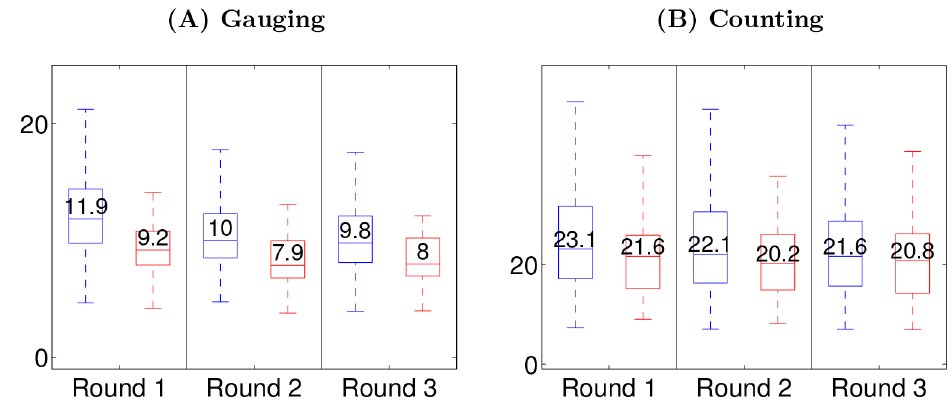
Fig 5. (A) gauging game ; (B) counting game . From left to right: (Boxplot 1, 3 and 5, in blue) Root mean square distance from individual opinions to truth ( E i ( r )); (Boxplot 2, 4 and 6 in red) Root mean square distance from mean opinion to truth. Values shown for the counting game have been scaled by a factor of